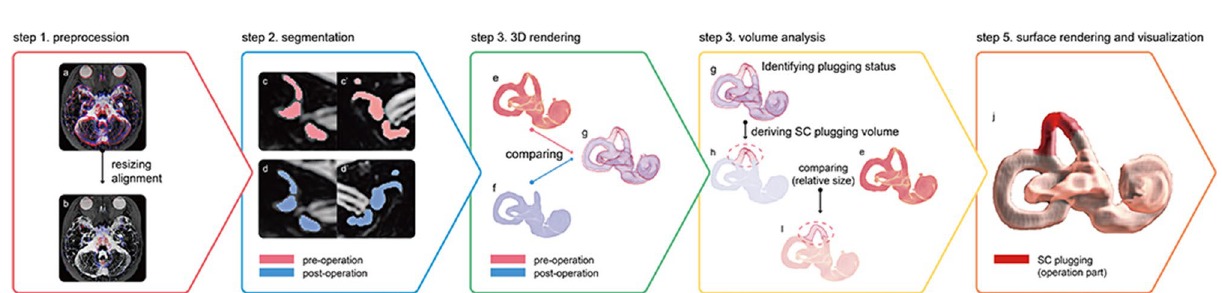
Figure 2. SC volume analysis workflow. ( a ) Pre- and post-operative magnetic resonance imaging (MRI) scans are overlaid (differences marked in blue and red). ( b ) Pre- and post-operative MRI scans after resizing and alignment. Segmentation of the vestibular system based on ( c ) pre- and ( d ) post-operative data. Volume rendering of the segmentation result based on ( e ) pre- and ( f ) post-operative data. ( g ) Overlay of ( f ) onto ( e ). ( h ) Manual removal of voxels outside the filling defect region. ( i ) Volume difference representing the filling defect after surgery (marked in blue). ( j ) Three-dimensional visualization based on surface rendering using direct volume rendering. The red architecture indicates the volume difference between preoperative and postoperative data and represents the filling defect after surgical plugging. This cartoon for the SC volume analysis workflow was illustrated by Adobe illustrator 2020 (https:// www. adobe.